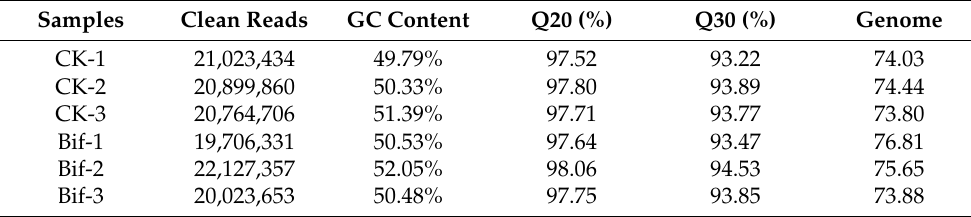
Table 2. Data output quality and mapping rates for the examined samples of Plutella xylostella .